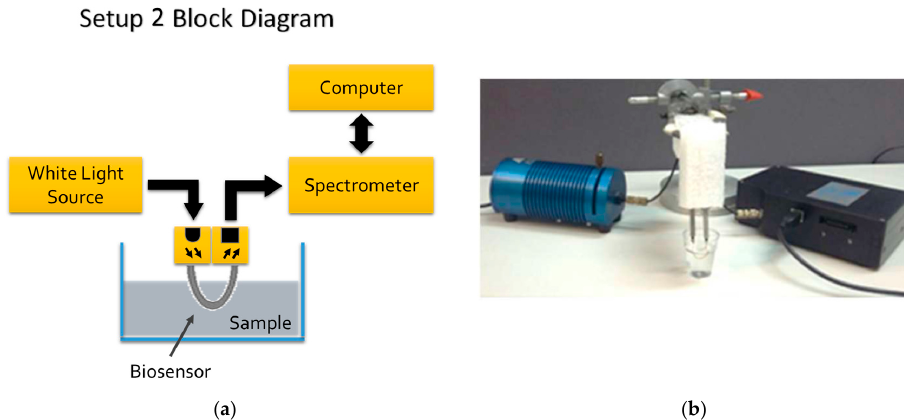
Figure 5. ( a ) Setup 2 block diagram; ( b ) Setup 2 picture. The white light source is at the left and the spectrometer at the right.